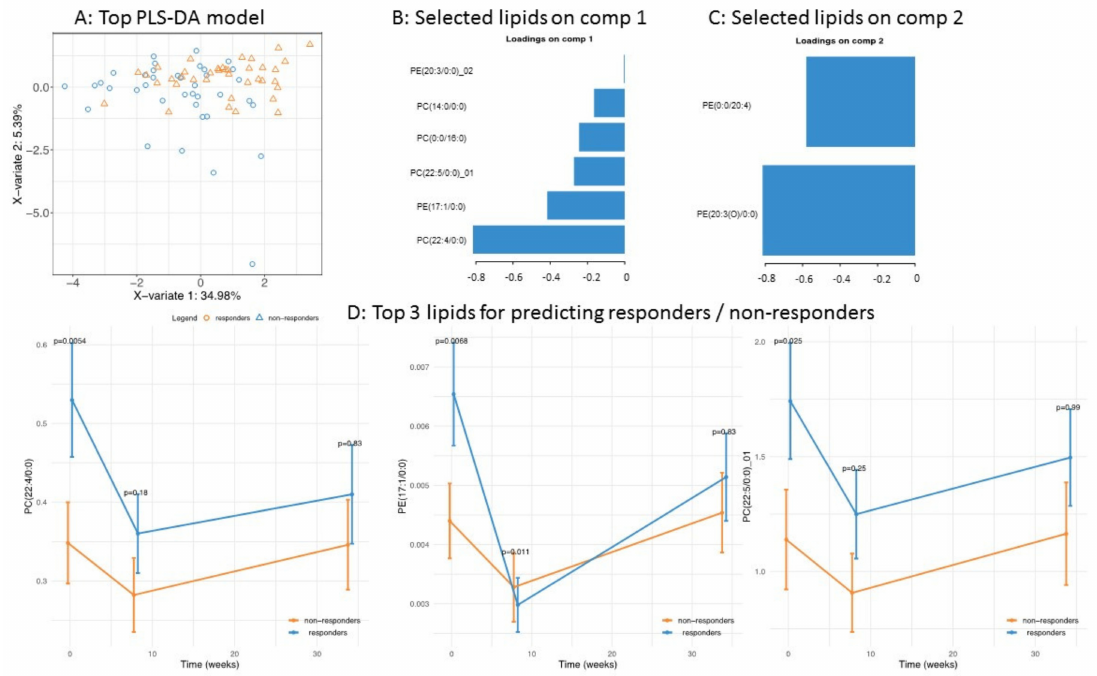
Figure 6. Top model was employed to predict weight loss responders and non-responders: ( A ) Score plot separating responders and non-responders; ( B , C ) lipids contributing to the prediction of PC1 and PC2; ( D ) time-series profile (during weight loss intervention) of the top three lipids in the PLS-DA